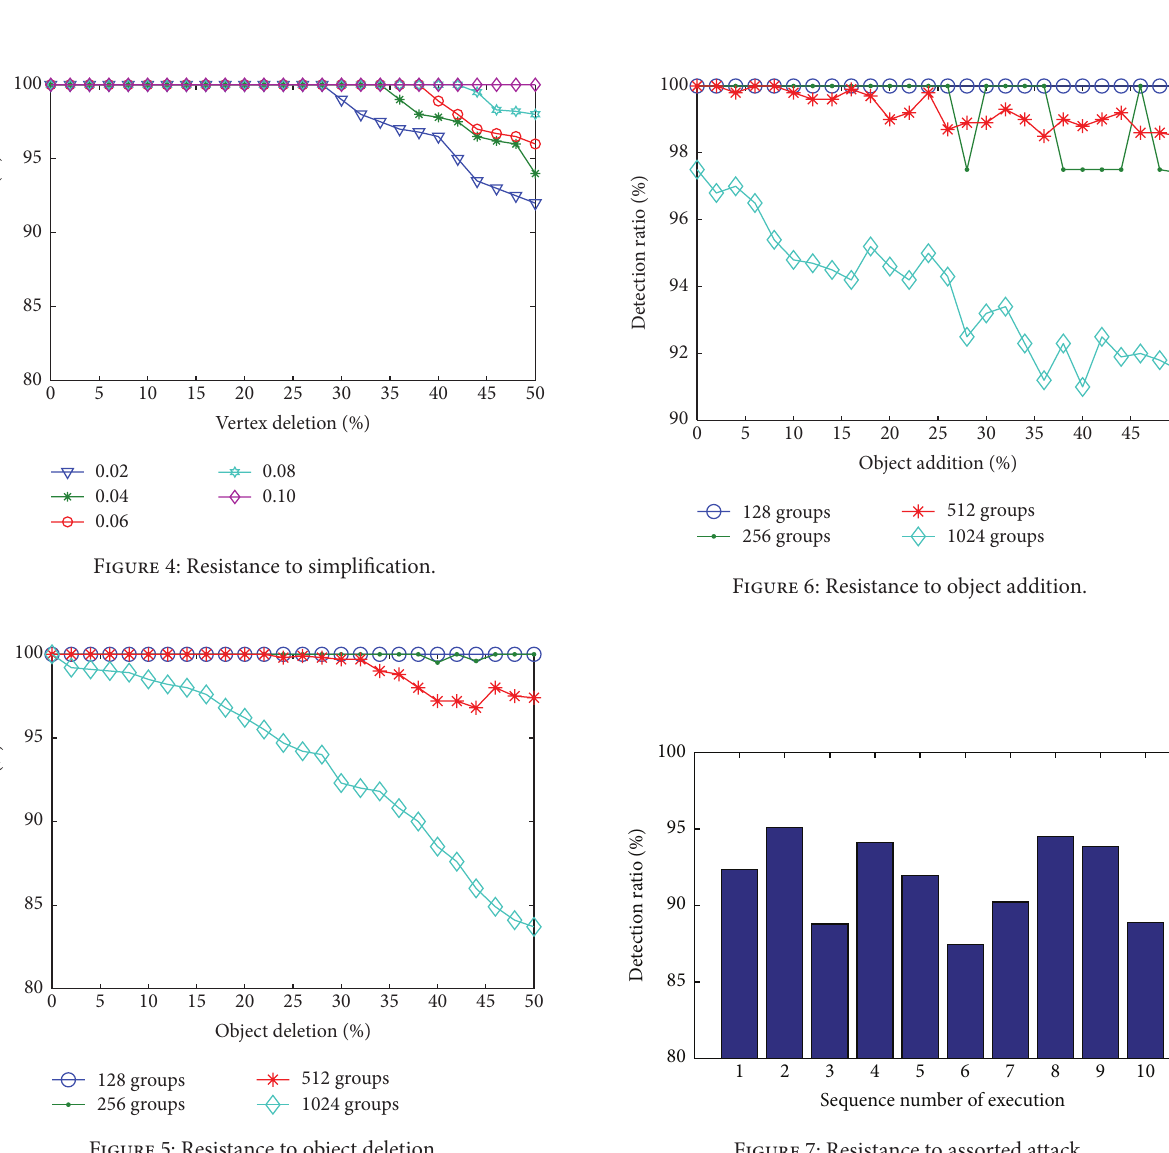
Figure 7: Resistance to assorted